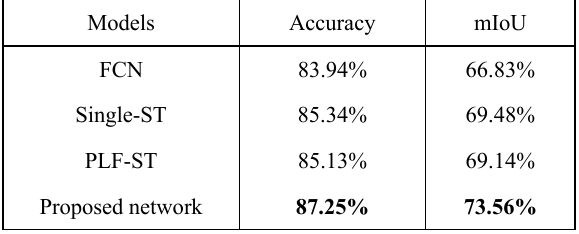
Table 1 . Performance comparison between proposed network and other